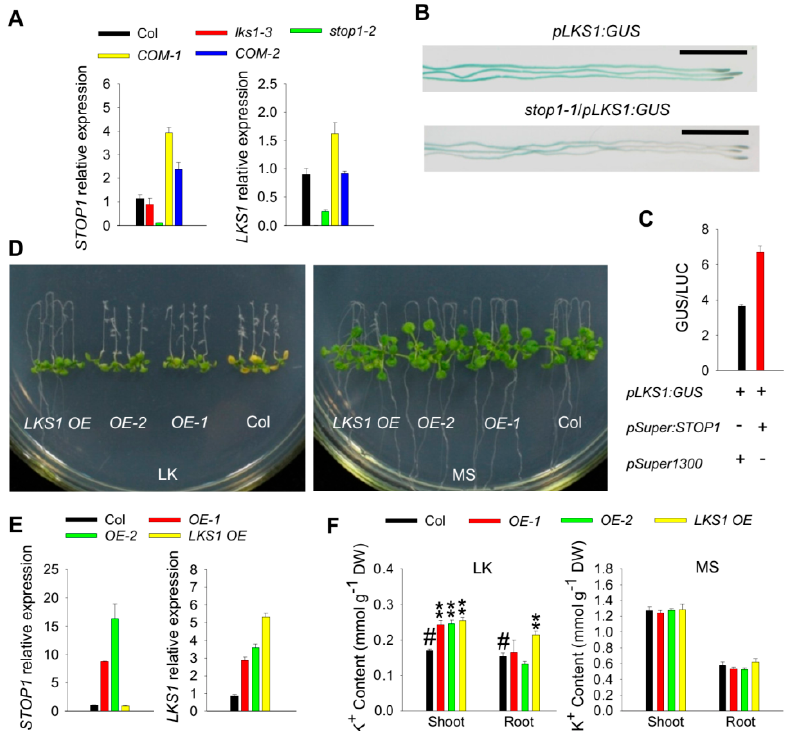
Figure 3. STOP1 positively regulates LKS1 transcription. ( A ) RT-qPCR analyses of STOP1 (left) and LKS1 (right) expression in wild type (Col), lks1-3 , stop1-2 , and complementation lines stop1- 2 / pSTOP1:STOP1 ( COM-1 and COM-2 ). Seedlings were germinated on MS medium for 7 days, and then roots were collected and used for RT-qPCR assays. Data are shown as means ± SE ( n = 3). ( B ) GUS staining showing LKS1 expression in the roots of wild type and stop1-1 mutant. Seedlings were germinated on MS medium for 6 days, and then used for GUS staining. Scale bars = 2 mm. ( C ) GUS activity measurement in tobacco leaves after transient expression of pLKS1:GUS and pSuper:STOP1 . LUC was used as an internal control. Data are means ± SE ( n = 4). ( D ) Phenotype comparison among LKS1 overexpressing line ( LKS1 OE ), STOP1 overexpressing lines ( OE-1 and OE-2 ), and wild-type (Col) plants . The 5 day old seedlings were transferred to MS or LK medium for 12 days. ( E ) RT-qPCR analyses of STOP1 (left) and LKS1 (right) expression in the roots of tested materials as indicated. Seedlings were germinated on MS medium for 7 days, and then roots were collected and used for RT-qPCR assays. Data are presented as means ± SE ( n = 3). ( F ) K + content measurement of indicated plants shown in ( D ). K + contents were measured after seedlings were transferred to MS or LK medium for 10 days. Data are shown as means ± SE ( n = 4). Student’s t -test (** p < 0.01) was used to analyze statistical significance; # represents the control.